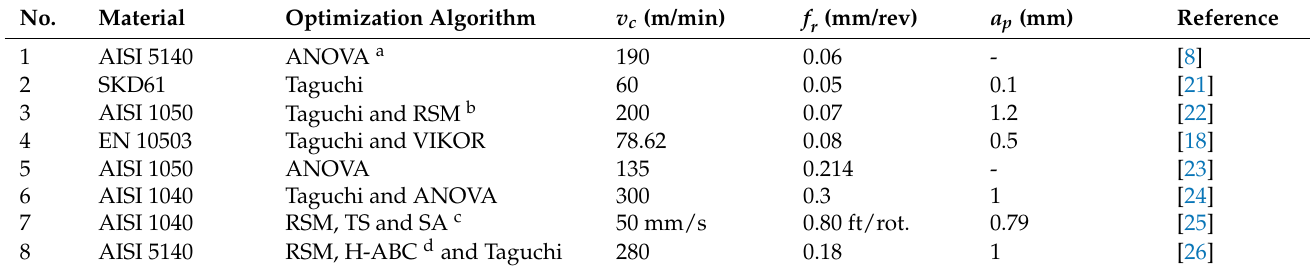
Table 1. List of research results in the